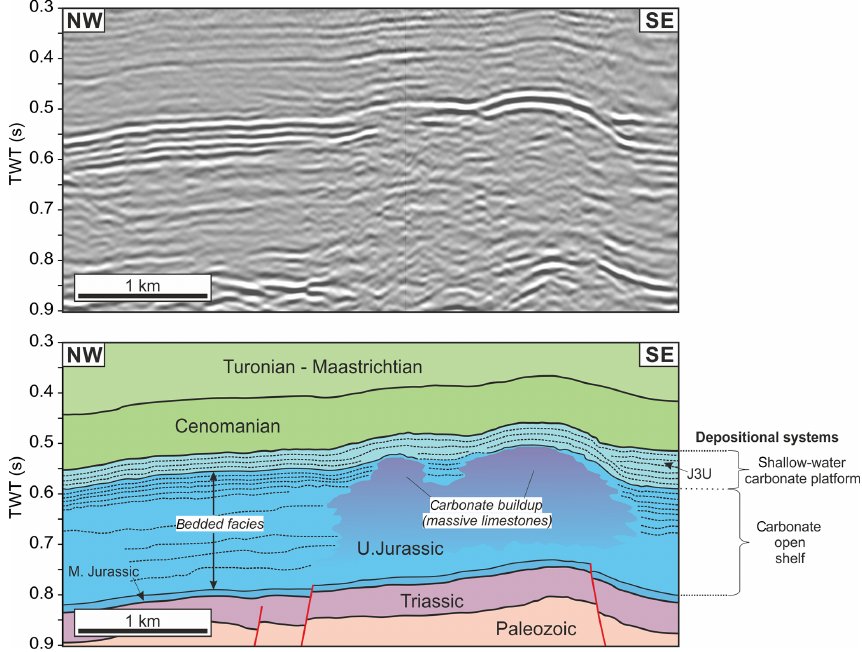
Figure 14. Uninterpreted and interpreted seismic profile across the carbonate buildup complex (see Fig. 5 for location). Lateral seismic facies changes correspond to main facies changes within the Upper Jurassic: bedded facies (represented by diverse bedded limestones and marls) to massive limestones (carbonate buildups).